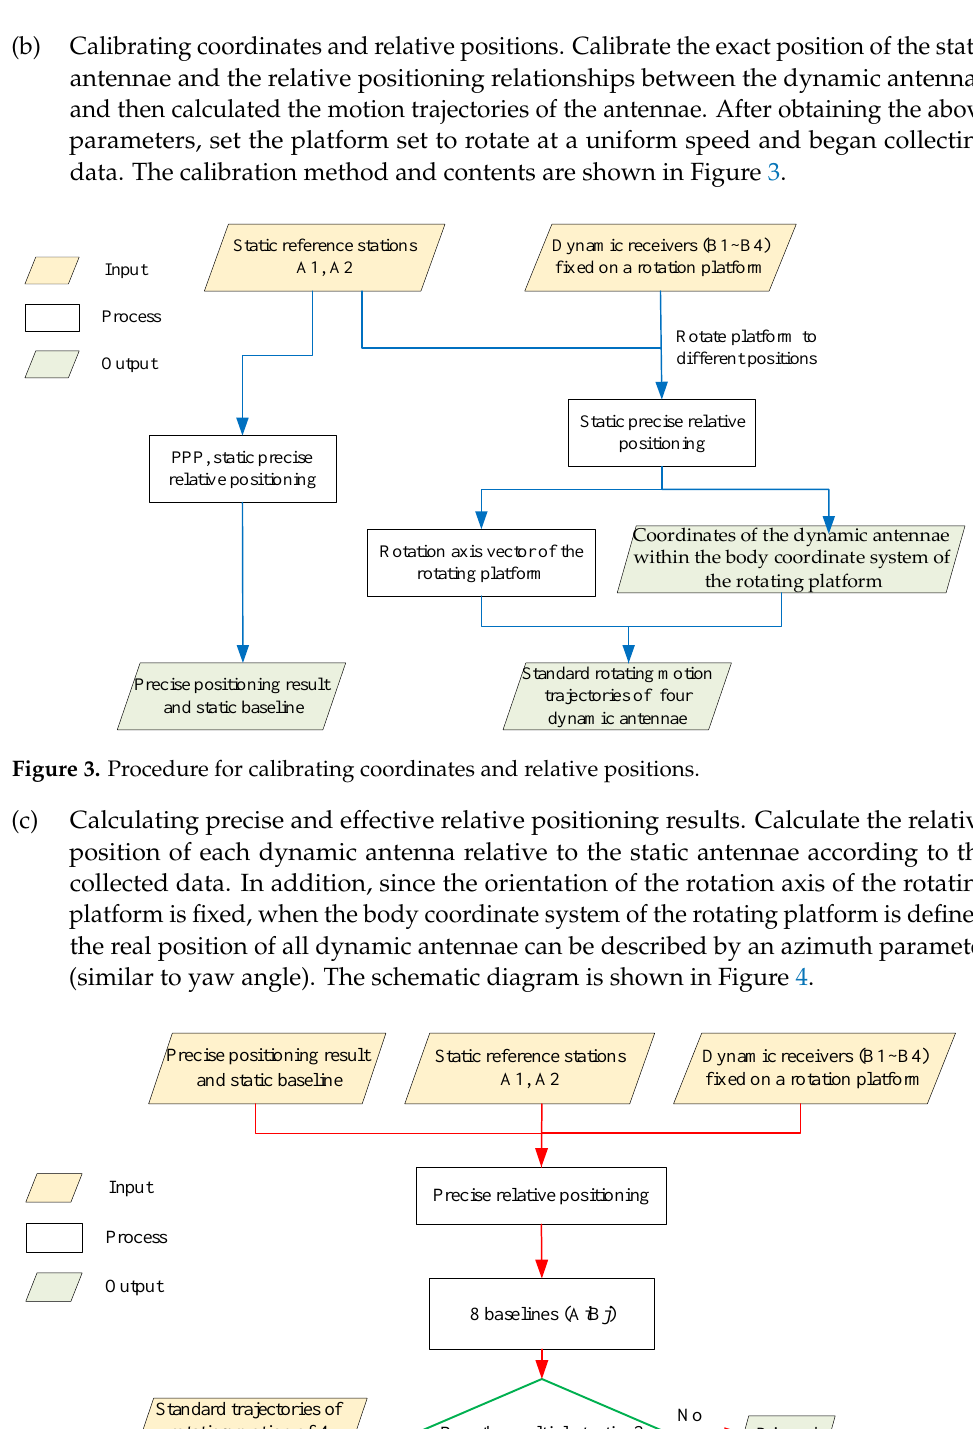
(b) (b) Calibrating coordinates and relative positions. Calibrate the exact position of the static antennae and the relative positioning relationships between the dynamic